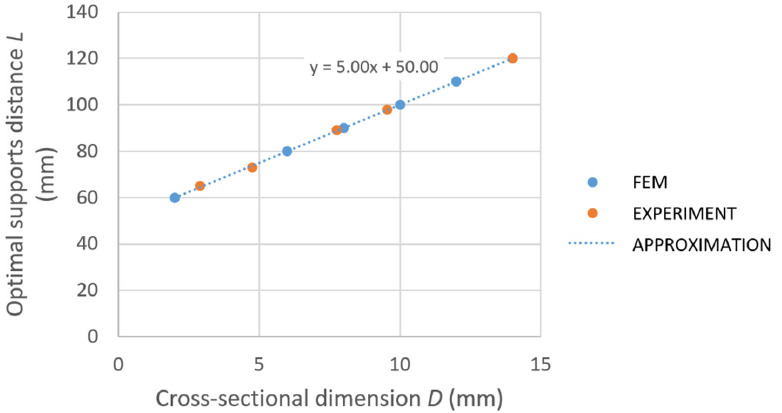
Figure 5. The dependency of the optimal distance of supports L on cross-section size D. FEM, finite element method.